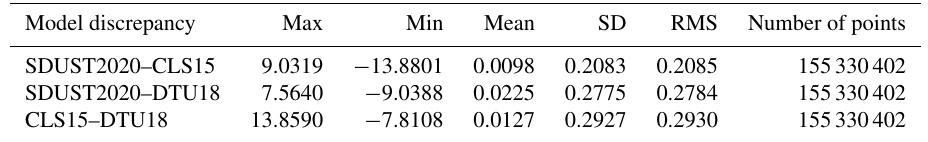
Table 5. Statistical results of comparisons between different mean sea surface models (unit: m).